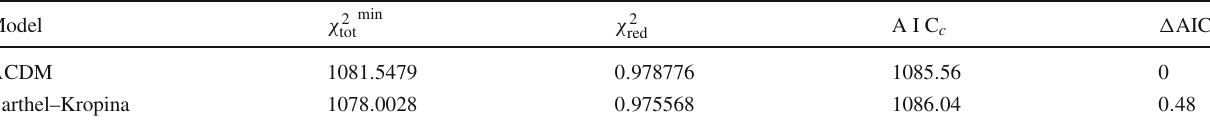
, AIC c and (cid:24) AIC c red